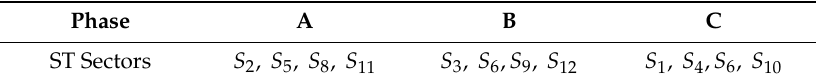
Table 3. Switching states of ST in each